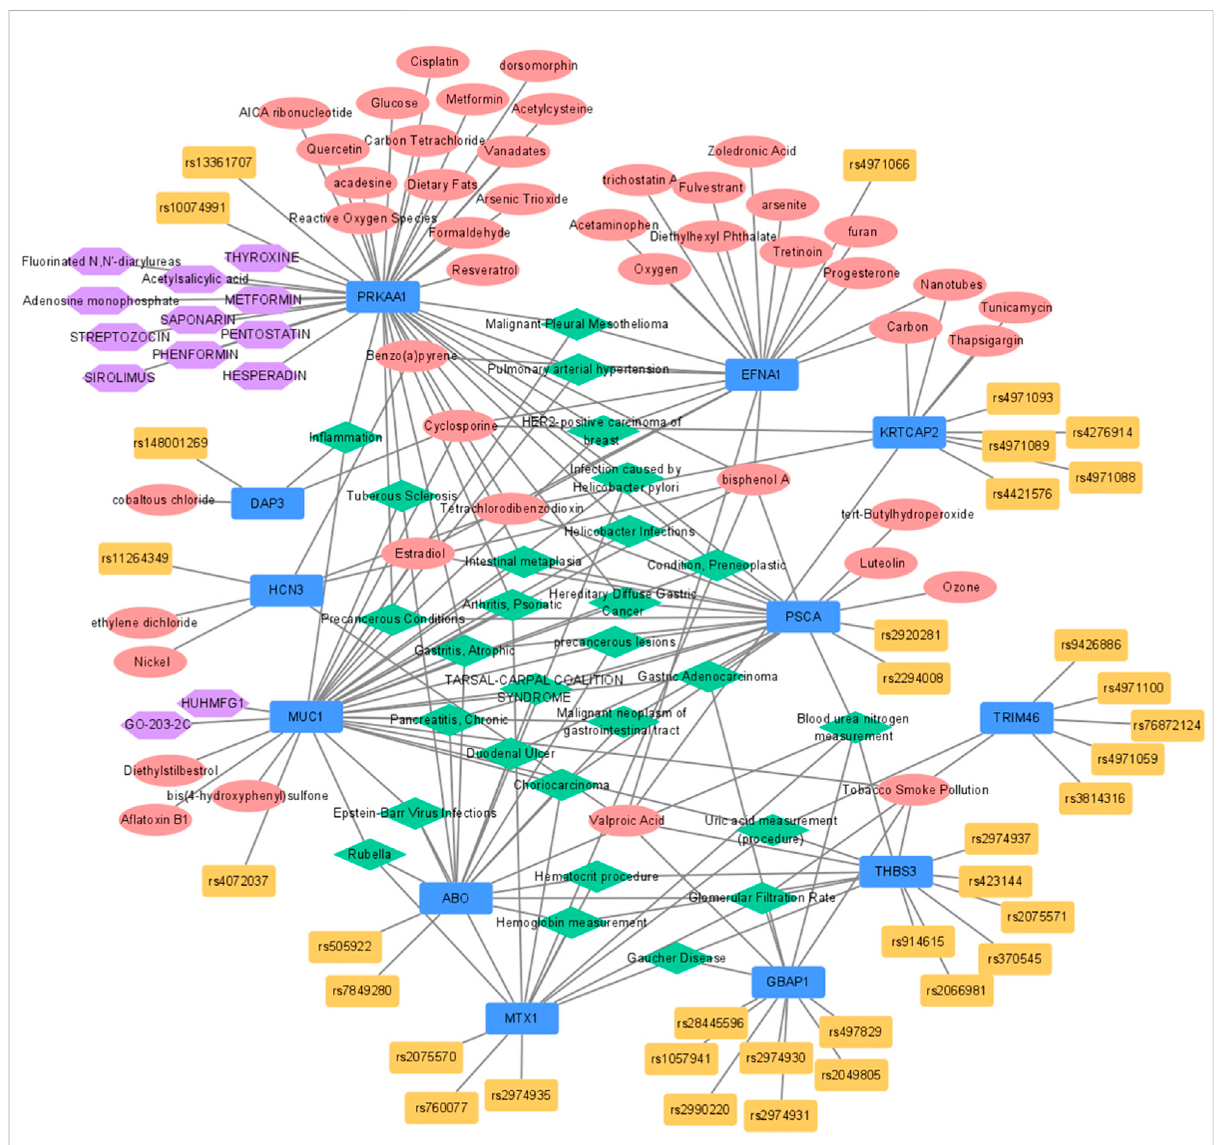
FIGURE 2 Functional network analysis for expression-regulated genes from eQTL identi fi ed by GBA. Blue, red, yellow, green, and purple nodes stood for genes, chemicals, SNPs included in GBA, disease-networks, and drugs, respectively. eQTL, expression quantitative trait loci; GBA, gene-based analysis; SNP, single nucleotide